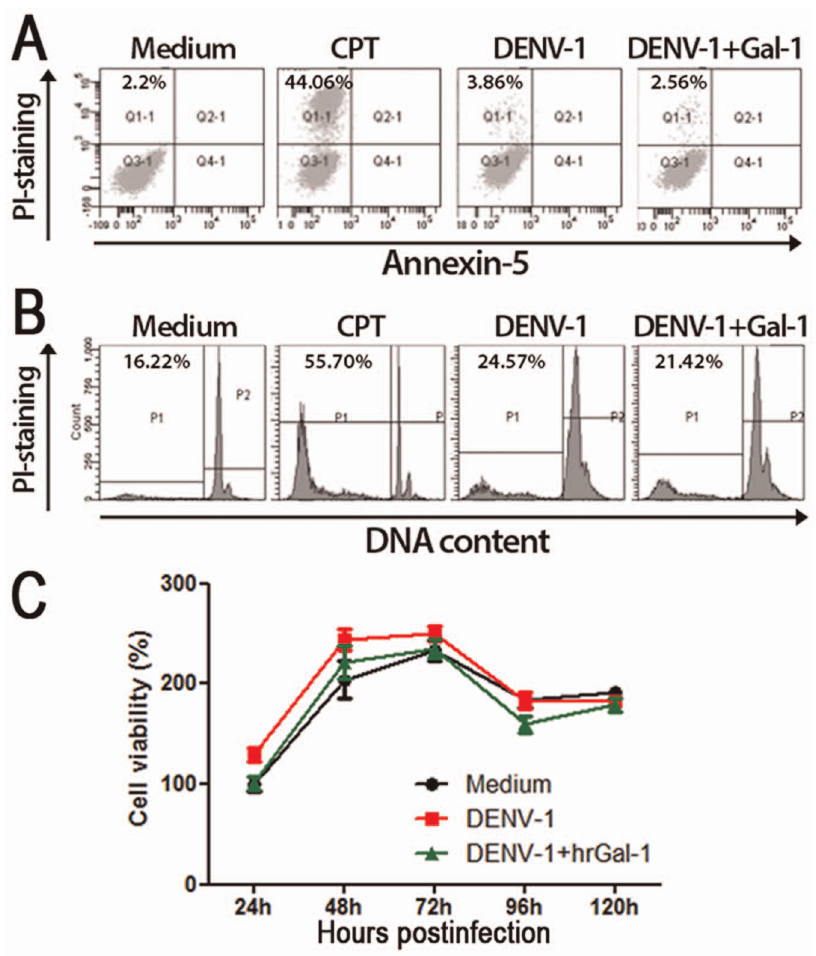
Figure 3. Gal-1 does not induce cell death during DENV-1 infection. (A and B) ECV-304 cells (2.5x10 4 ) were treated with hrGal-1 (10 m M) and infected with DENV-1 (MOI 0.5). At 72 hours postinfection, PI staining was used to evaluate the membrane permeability (A) and DNA degradation (B). For these purposes, PI was added to fresh cells or to permeabilized cells, respectively. Samples were acquired and analyzed by flow cytometry. Data is representative from three experiments with similar results. (C) ECV-304 cells were treated or not with 10 m M of hrGal-1 and infected with DENV-1 as described in (A). At the indicated times postinfection, cell viability was examined by MTT assay. Cells cultivated only with medium at 24 hours were designated as 100% of cell viability. Data is representative of 3 independent experiments performed in